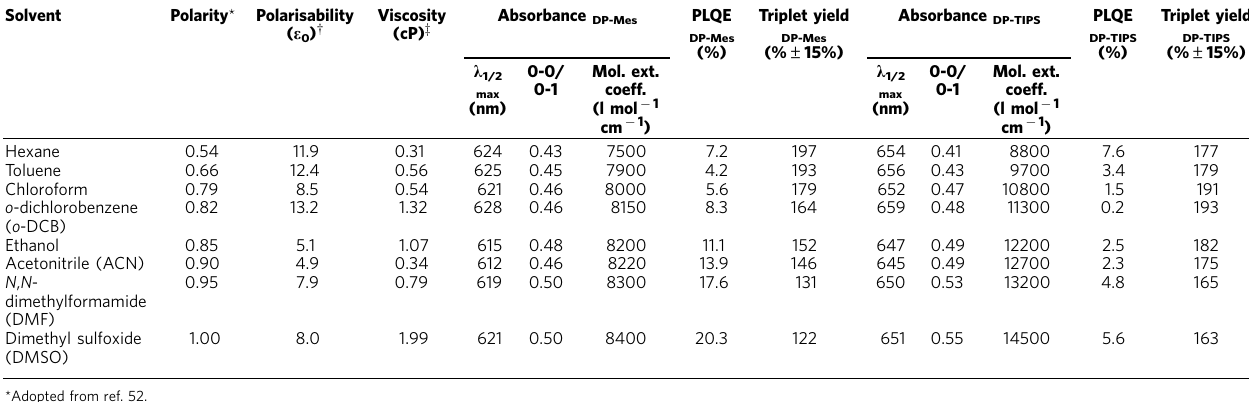
Table 1 | Solvent properties and solvent-dependent absorption, PLQE and triplet yield parameters of DP-Mes and DP-TIPS. Solvent Polarity * Polarisability ( e 0 )